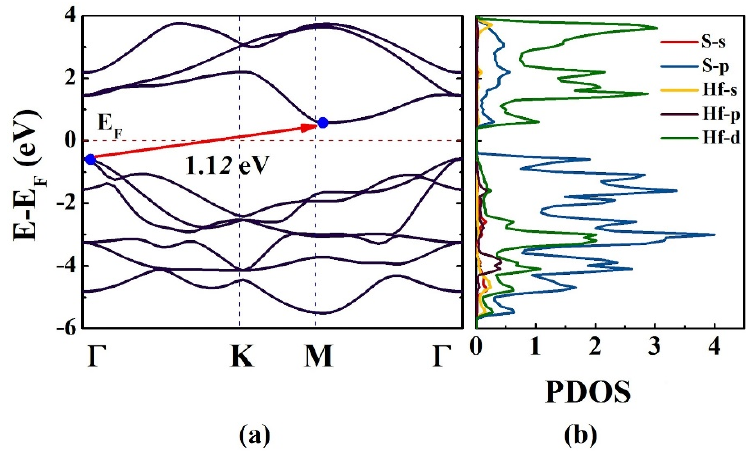
Figure 5. Band structure ( a ) and PDOS ( b ) of the HfS 2 monolayer in free-strain condition. The Fermi level is set to zero.